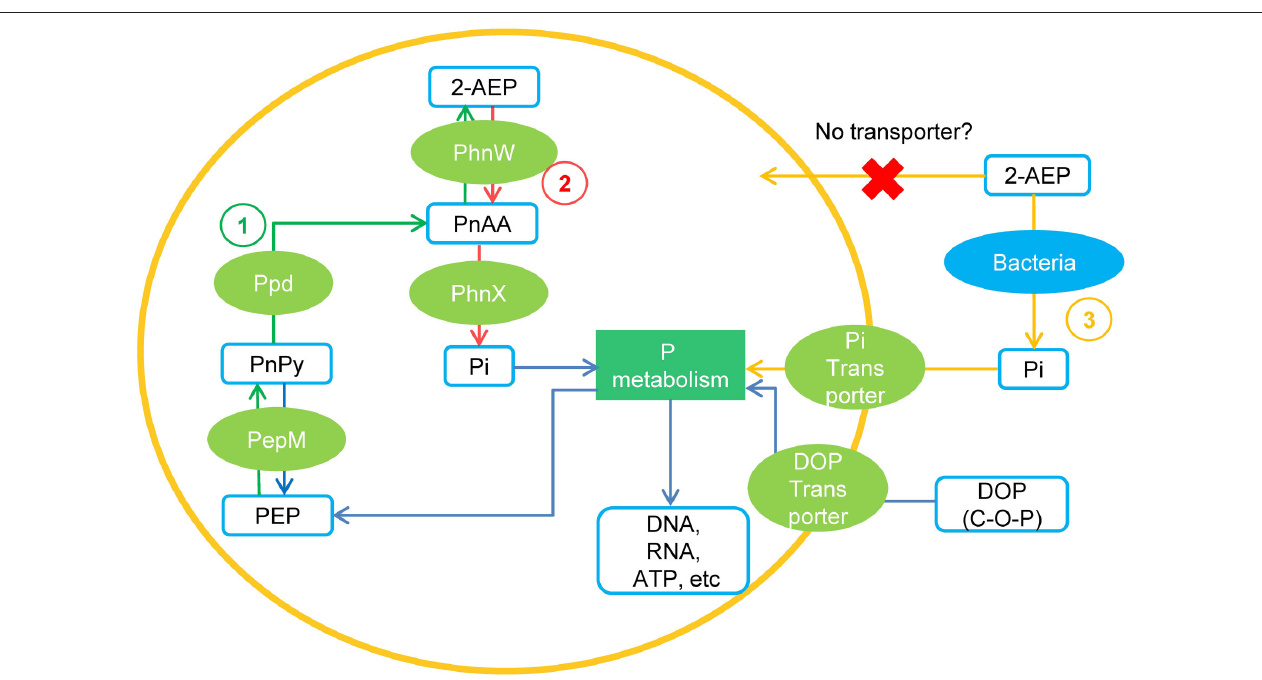
FIGURE 5 | A conceptual model of 2-AEP metabolism in dinoflagelates inferred from current data. (1) Pathway of 2-AEP biosynthesis in the algal cells; (2) Pathway of 2-AEP metabolism (recycling) inside the algal cells. (3) Pathway of dinoflagellates obtaining P i from environmental 2-AEP through the mediation of bacteria. PEP, phosphoenolpyruvate; PnPy, phosphonopyruvate; PnAA,